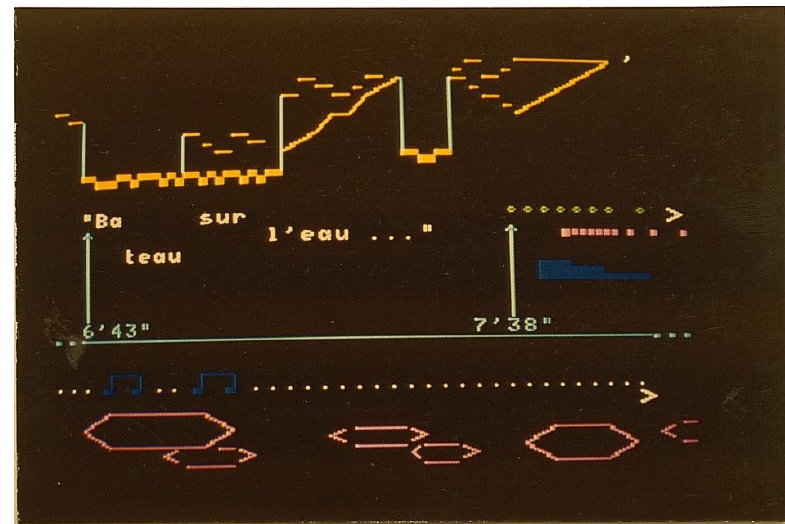
Figure 8. Image from “Mosaïque 7”, project by the composer Francis Miroglio for Art Accès . Collection Frédéric Develay © Kandinsky Library, MNAM/CCI, Centre Pompidou.